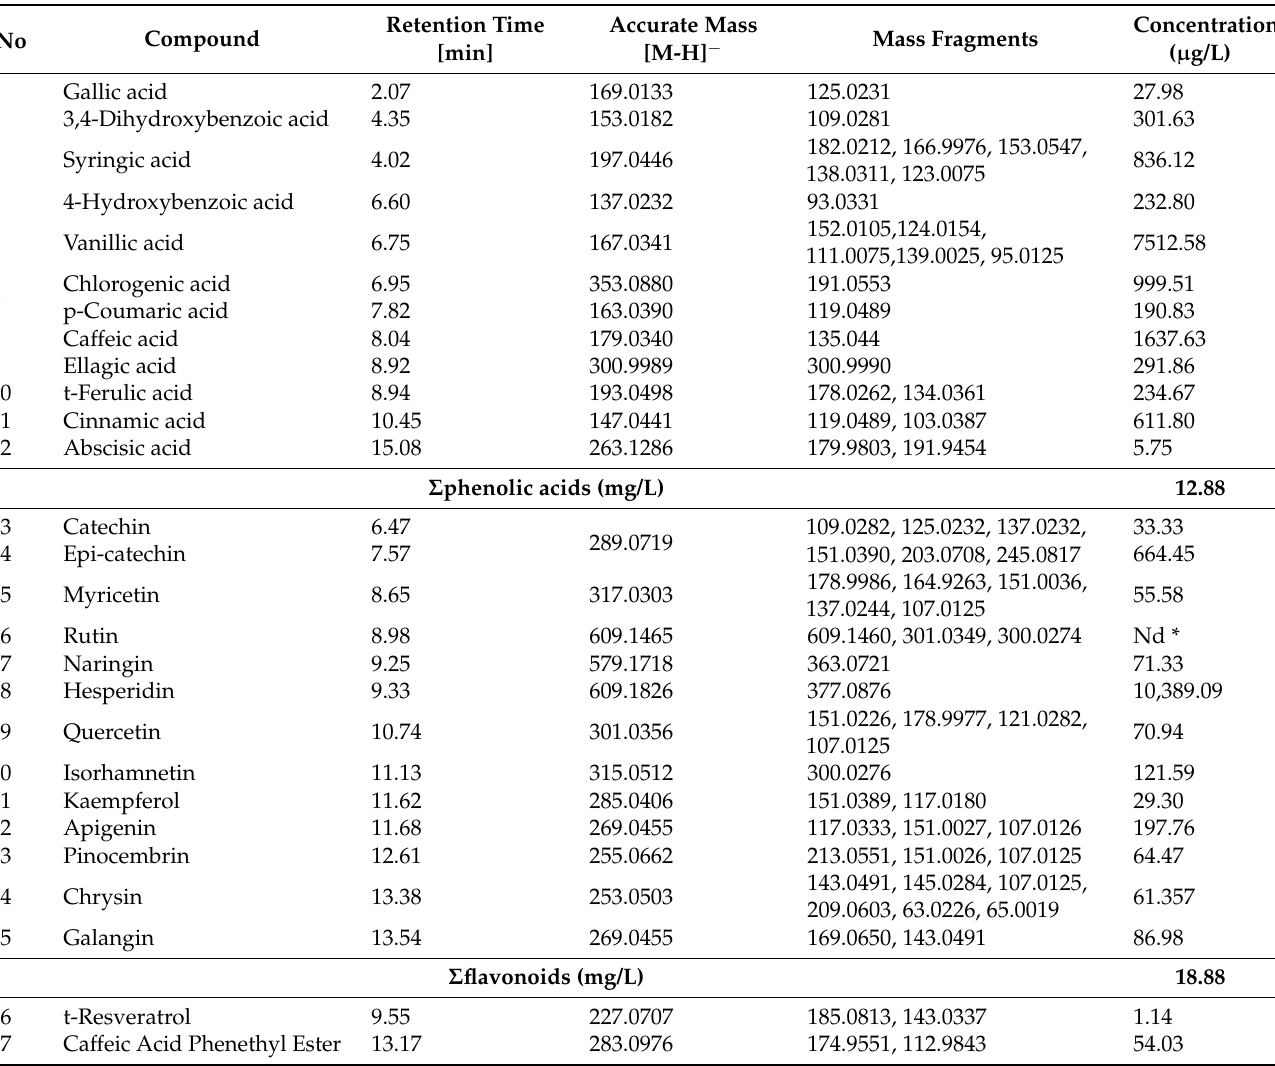
Table 2. Identification and quantitative data of phenolic compounds in the R. officinalis extract using extract UHPLC-MS/MS in negative ionization